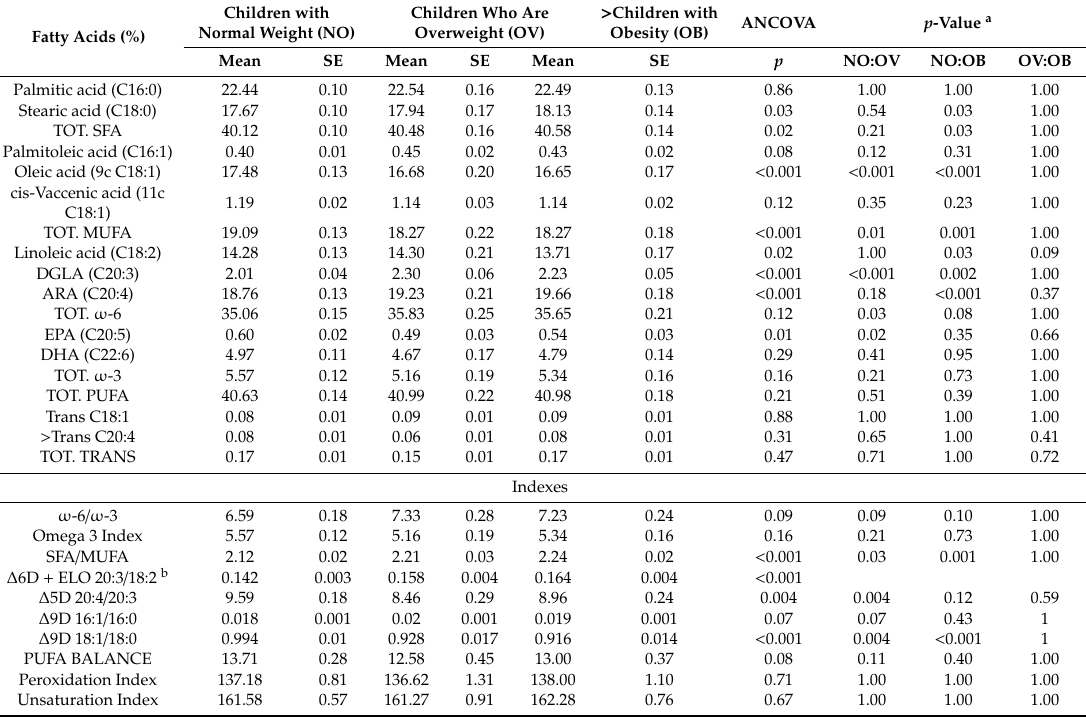
Table 3. Red blood cell (RBC) membrane fatty acid